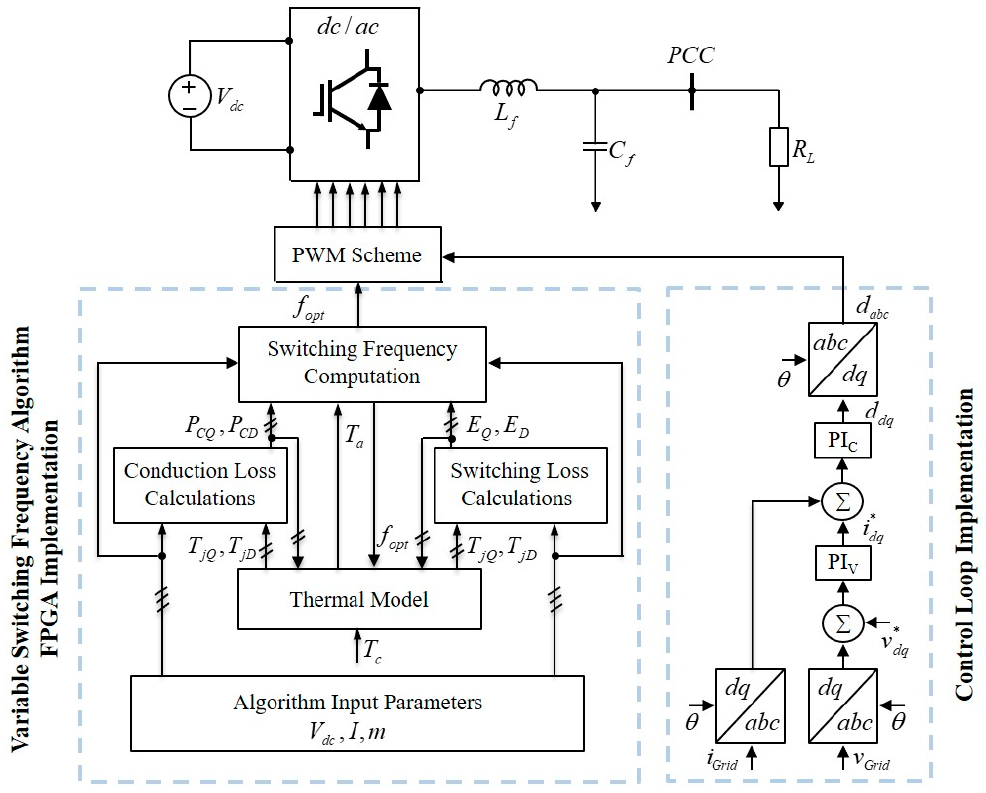
Figure 1. Grid-feeding VSI associated with the proposed VSF algorithm. PWM: pulse width modulation.